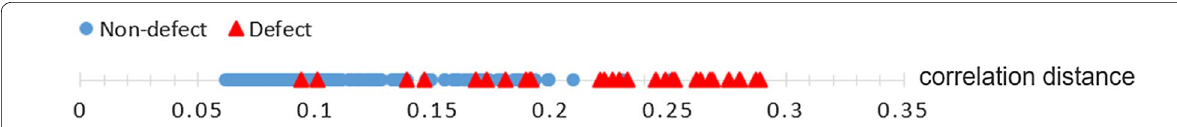
Fig. 8 Non-defective and defective samples for the 15° delamination test block plotted according to the correlation distance from the devised model. It can be noticed that non-defective samples have lower values than defective samples as the model successfully represents the